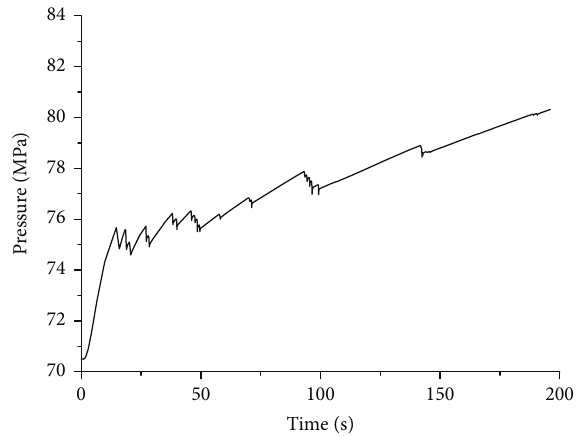
Figure 10: Pressure curve at the NF approaching angle of 30 ° and the stress anisotropy coe ffi cient of